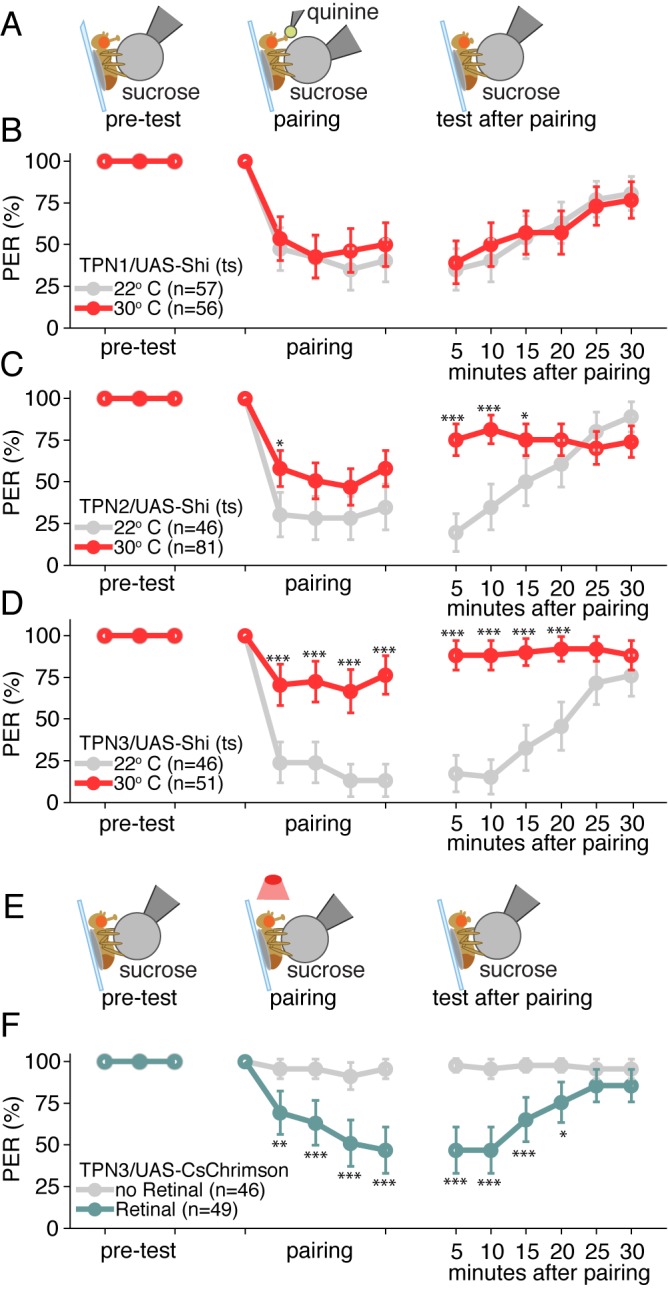
Taste projection neurons are essential for conditioned taste aversion.(A) Schematic of aversive taste memory protocol experiments with flies expressing Shits in TPN1, TPN2 or TPN3. Flies were initially presented with 500 mM sucrose (pre-test) and only flies that showed reliable PER were included for the remainder of the experiment. Next, flies were presented with sucrose on their legs and their proboscis was touched with bitter 50 mM quinine upon PER (pairing). Finally, flies were presented with sucrose to the legs in 5 min intervals to test memory after pairing. (B) Aversive taste memory upon conditional silencing of TPN1 shows unimpaired memory at restrictive (30°C) temperature (red) when compared to permissive room temperature flies (gray), indicating TPN1 is not required for memory. (C) Conditional silencing of TPN2 shows impaired memory at restrictive temperature, specifically in tests after pairing, suggesting TPN2 is required for memory. (D) Conditional silencing of TPN3 produces defects during training and post-training, showing TPN3 is required for memory. (E) Schematic of aversive taste memory protocol experiments with flies expressing CsChrimson in TPN3. Experiments were conducted as described in A, except during pairing: proboscis stimulation with quinine was replaced with red light stimulation (i.e. activation of TPN3). (F) Activating TPN3 with CsChrimson, which replaces bitter application during training, serves as a US to produce robust learning. For B,C,D,F, error bars are 95% CI; for each CS presentation, the difference between the control and experimental conditions (e.g. gray and colored data points) were tested with Fisher’s Exact Tests with Bonferroni adjusted alpha levels of *p<0.005 (0.05/10), **p<0.001 (0.01/10), ***p<0.0001 (0.001/10).